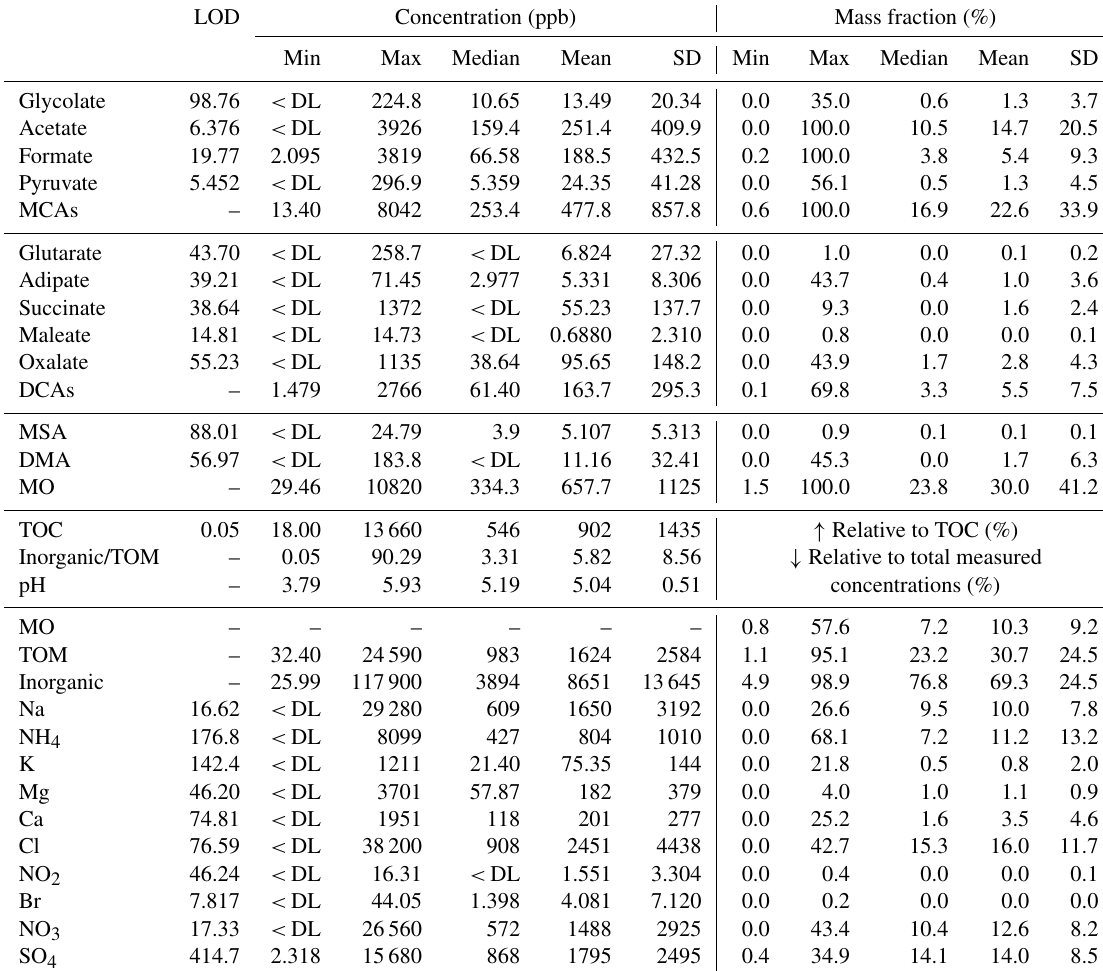
Table 1. Mass concentration limits of detection (LODs), minimum, maximum, mean, 1 standard deviation, and median values (ppb; left), in addition to the mass fraction (%; right) for the 159 CAMP 2 Ex cloud water samples with TOC data; note that mass fraction values depend on the C mass of each organic species shown. Total measured mass is defined as the sum of TOM, Na + , NH + Br − , NO − , and SO 2 − . The abbreviations used in the table are as follows: MCAs – monocarboxylic acids, DCAs – dicarboxylic acids, MSA 3 4 – methanesulfonic acid, DMA – dimethylamine, MO – measured organics, TOM – total organic matter, and DL – detection